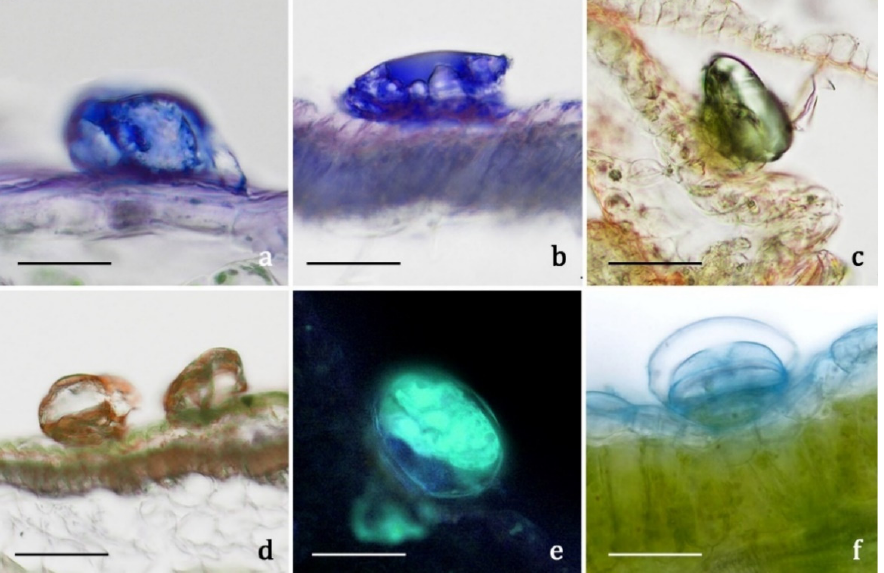
Figure 8. LM and FM micrographs showing the histochemical results on the secretory materials of the biseriate glandular trichomes of Achillea moschata . ( a , b ) Nadi reagent. ( c , d ) Ferric Trichloride test. ( e ) Aluminum Trichloride test. ( f ) Alcian Blue test. Scale bars: 30 µ m ( a , b , e , f ); 50 µ m ( c , d ). These observations were consistent with previous contributions on congeneric